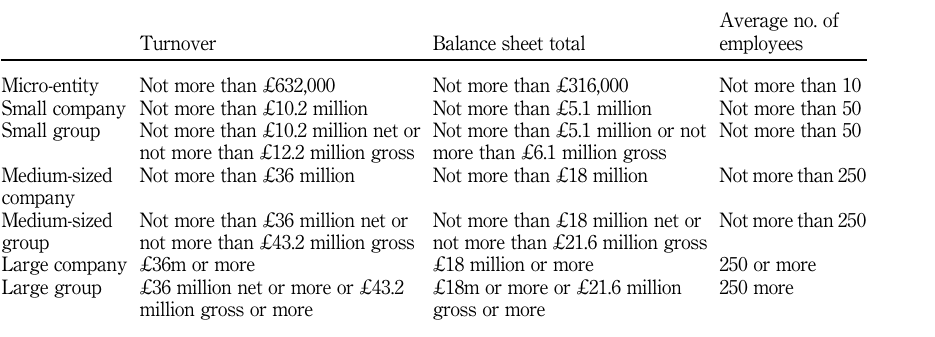
Table I. Criteria